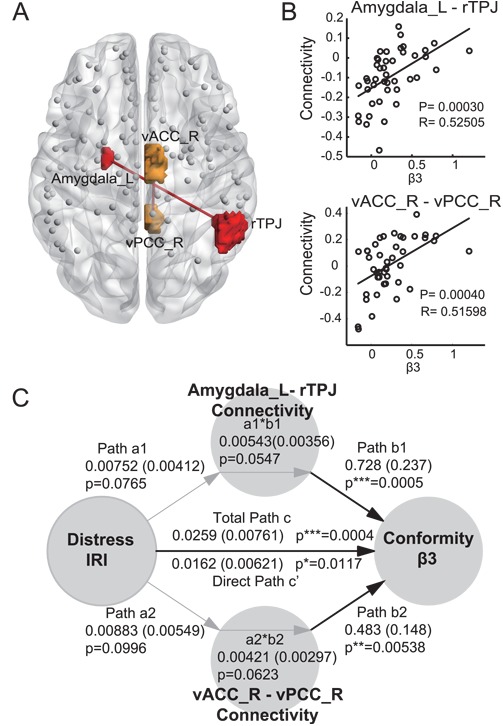
Correlation of brain network links with behavioral parameters and personality traits. β3 (Conformity) had a positive correlation with brain network links. (A) Red edges show brain network links that correlated with β3 (P < 0.0005). (B) Each participant’s strength of connectivity and β3 (similar to Figure 3B). (C) Mediation analysis of the functional connectivity on the link from Personal Distress to Conformity (β3). Path coefficients are shown next to arrows with standard errors in parentheses. Paths a1 a2 and b1 b2 represent the relationship of Personal Distress to Connectivity, and from Connectivity to Conformity while controlling for Personal Distress. Path c’ represents the direct relationship from Distress to Conformity controlling for Connectivity, and c represents the total relationship of Personal Distress to Conformity (not adjusted for any other factors). P*** < 0.001, P** < 0.01, P* < 0.05, two-tailed. Black and gray arrows show significant and marginally significant (0.05 < P < 0.1) relationships, respectively.